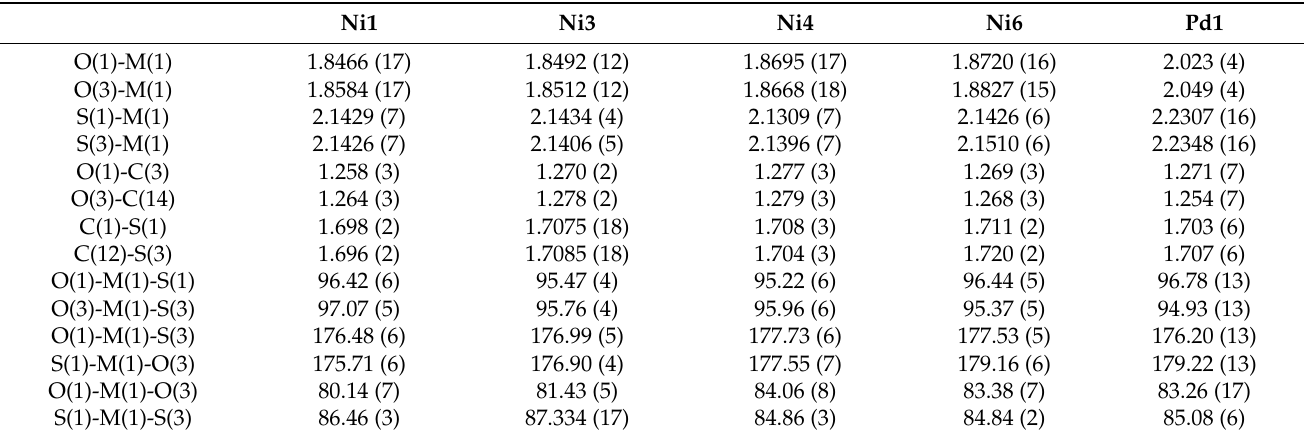
Table 2. Specific bond angles [ ◦ ] and bond lengths [Å] for nickel(II) and palladium(II) complexes Ni1-Ni6 and Pd1. Additional data are shown in Table S1.